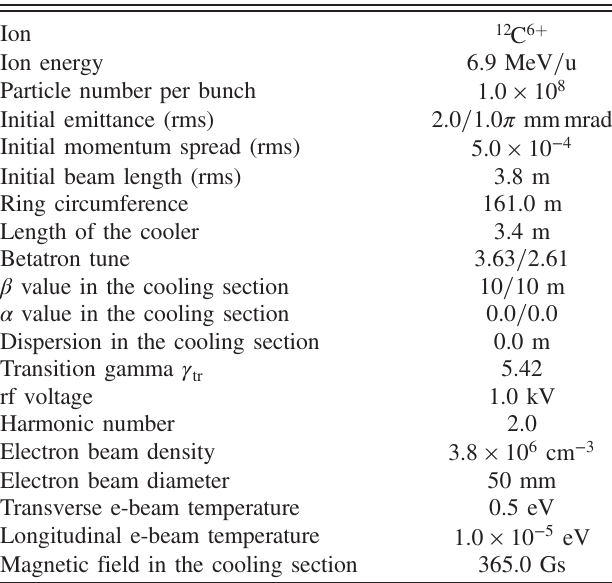
TABLE I. Initial parameters used in simulation.